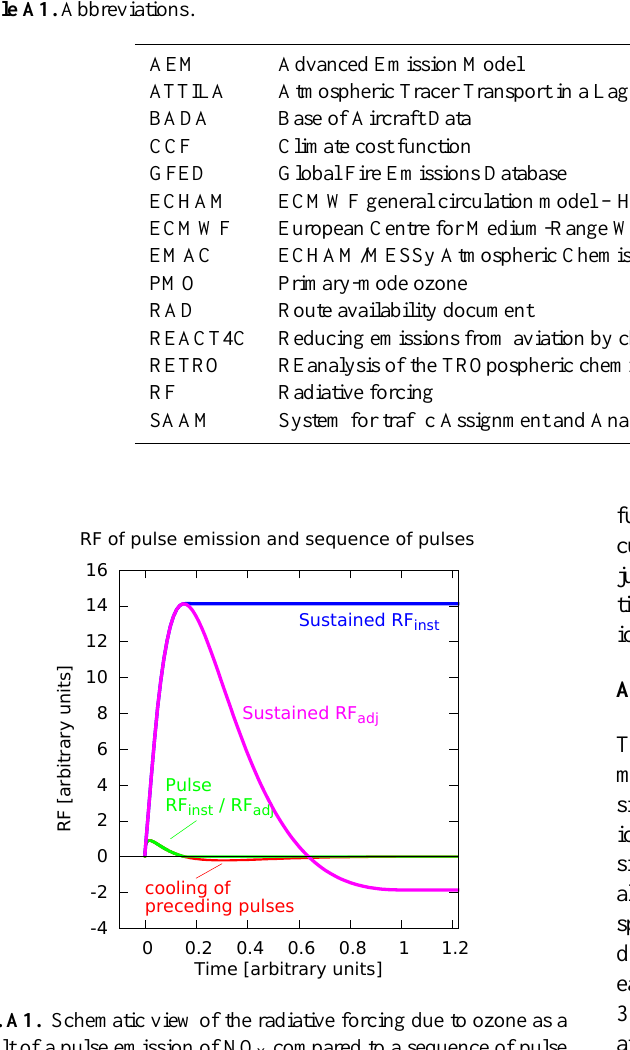
Table A1. Abbreviations.